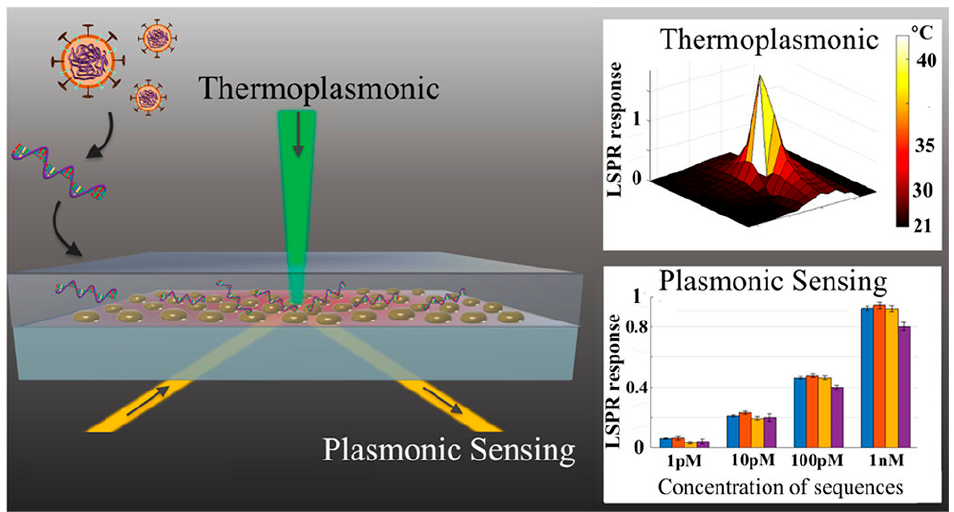
Figure 15. Schematic representation of two-dimensional gold nanoislands functionalized with complementary DNA receptors, mapping the temperature distribution around the plasmonic photothermal (PPT ) heat source and concentrations of various viral oligos measured using the dual-functional LSPR biosensors. An excitation laser with 532-nm peak wavelength and 40-mW maximum optical power was applied onto the gold nanoislands (AuNI ) chip in the normal incident angle to improve the conversion efficiency of thermoplasmonic. Adapted with permission from Qiu et al. [75] Copyright © (2020) American Chemical Society.